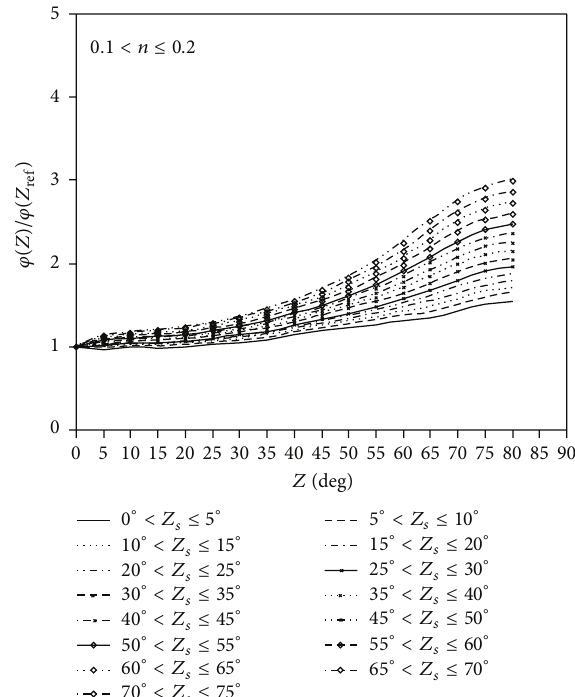
Figure 7: An example of the curves 𝜑(𝑍)/𝜑(0) versus 𝑍 for cloud index 0.1 < 𝑛 ≤ 0.2 and different values of solar zenith angles 𝑍 𝑠 . 𝑍 is the zenith angle of the sky subzone.